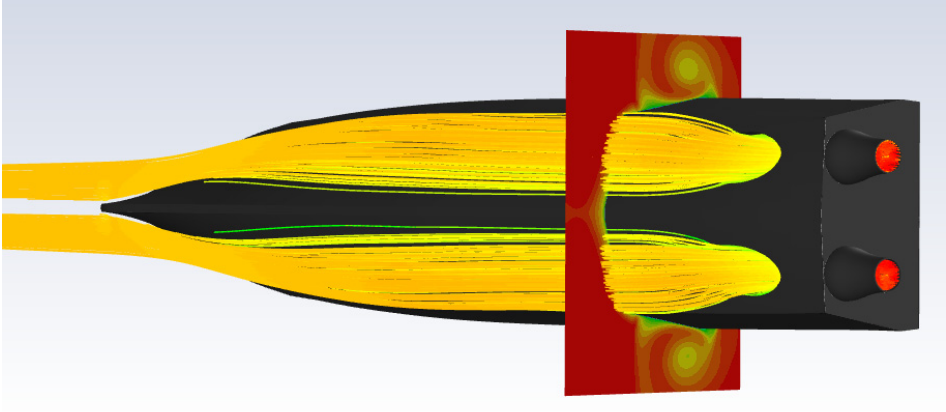
Figure 13. Waterjet streamlines calculated by RANS intersecting station 1a boundary layer.